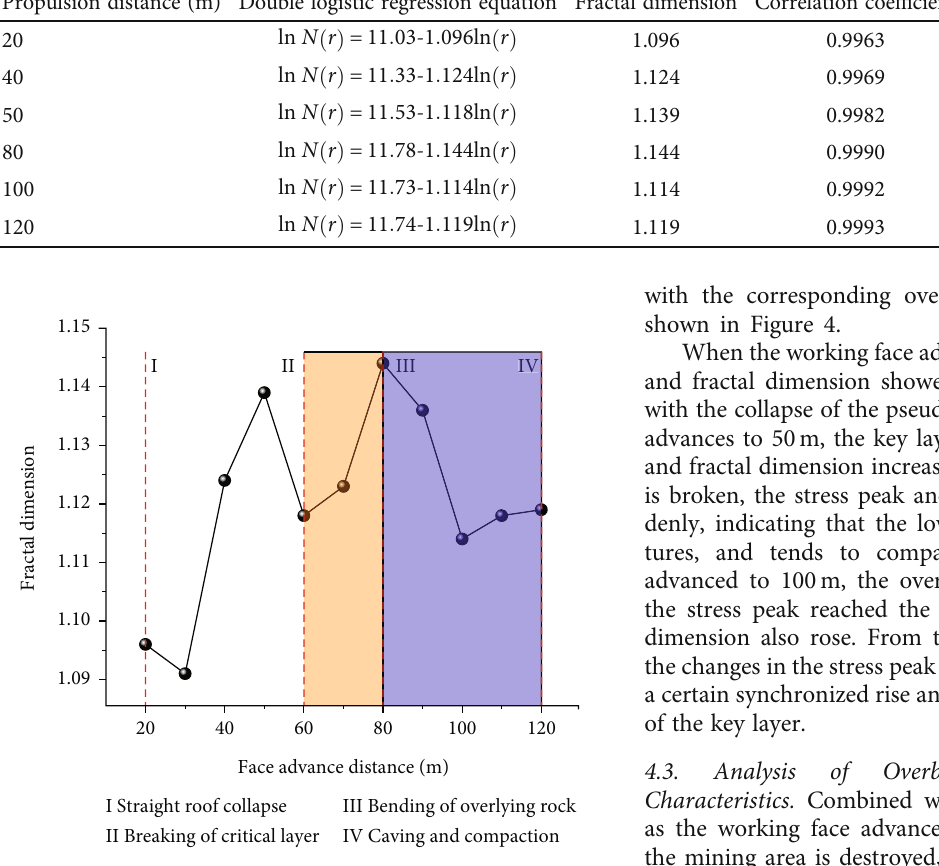
Figure 3: Fractal dimension of the rift network versus advance